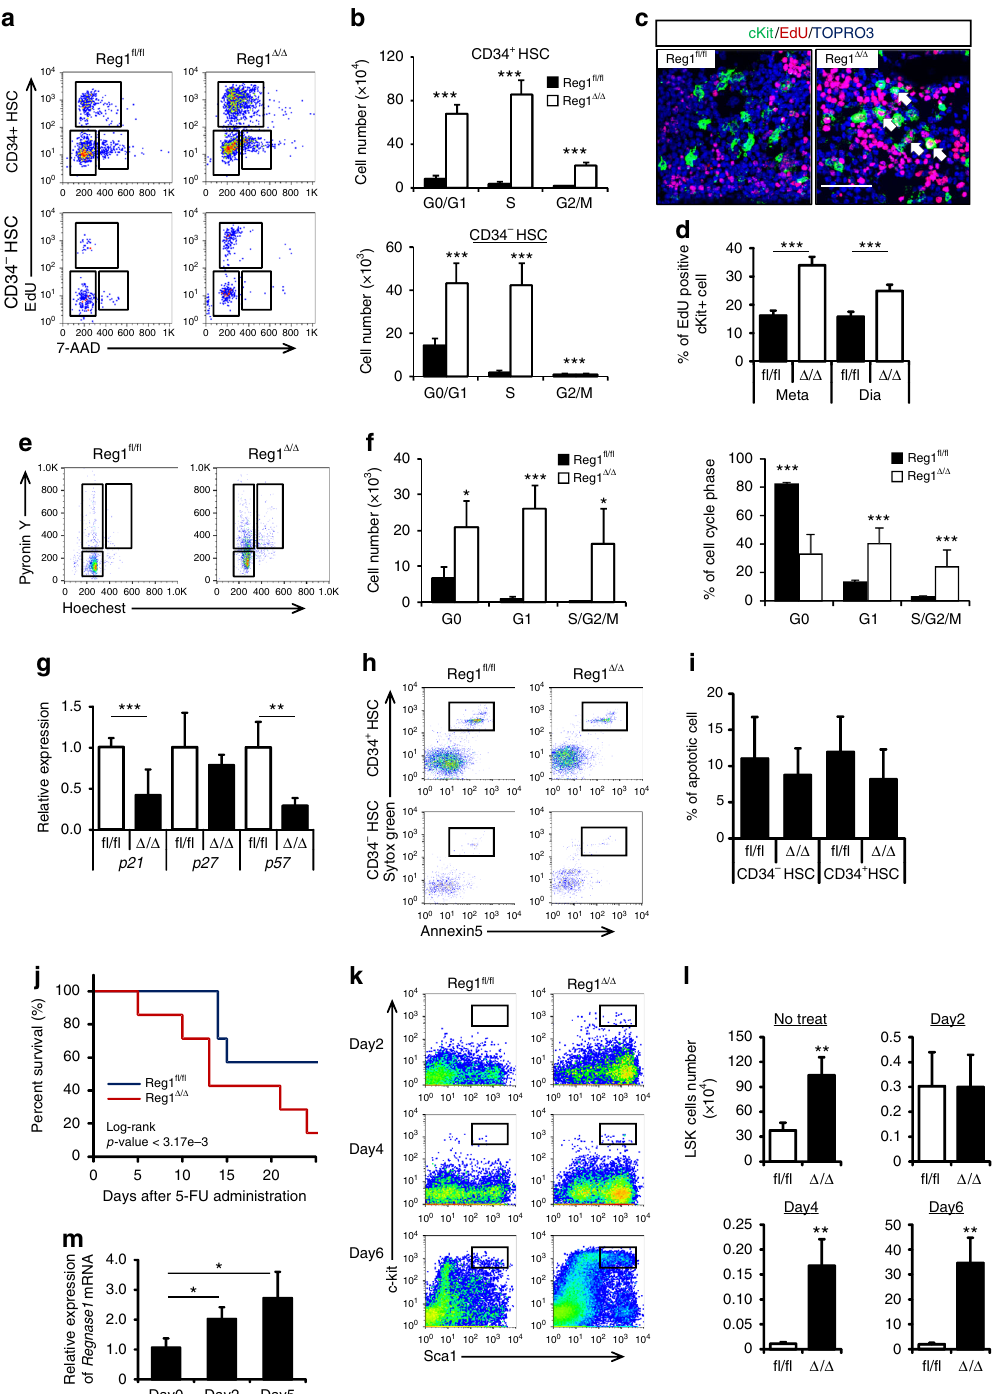
similar to an a priori- de fi ned set of genes in HSCs from Pu.1-de fi cient mice, taken to model AML (Fig. 5g). A comparison of gene expression sets between CD34 − HSCs from Regnase-1- deleted mice and BM from human AML-M1, M2, and M3 patients indicated signi fi cantly similar concordant differences in gene expression between Regnase-1-deleted CD34 − HSCs and human AML cells (Fig. 5h). Although Regnase-1 mRNA expression was not associated with prognosis, patients whose AML cells exhibited gene expression pro fi les similar to Regnase- 1-de fi cient CD34 − HSCs had a poor prognosis (Fig.